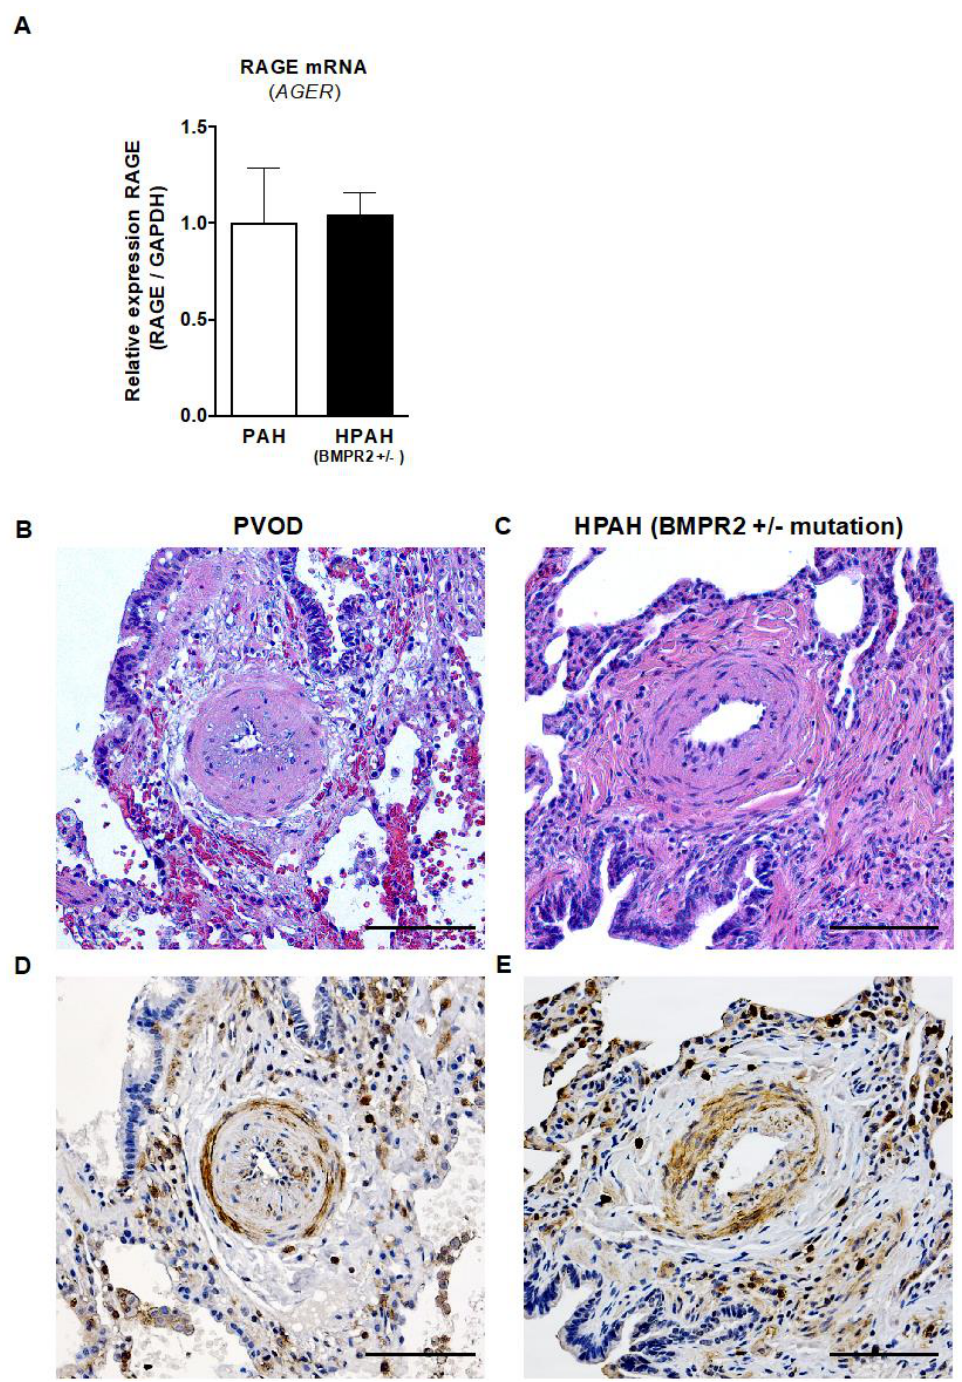
Figure 6. RAGE mRNA expression and immunohistochemistry in children with end-stage PAH and HPAH (heterozygous BMPR2 mutation). ( A ) The relative RAGE mRNA expression in children transplanted for idiopathic PAH or pulmonary veno-occlusive disease (IPAH + PVOD = PAH, n = 6) vs. children with heritable PAH (HPAH, BMPR2 +/ − mutation, n = 4) shows that a heterozygous BMPR2 mutation does not influence the relative RAGE mRNA expression in whole lung tissues from patients undergoing lung transplantation. Values are presented as mean ± SEM. Statistical test: Mann–Whitney U. ( B , C ) H&E images of distal pulmonary arteries of an 11-year-old patient with PVOD (B) and a 5-year-old patient with BMPR2 +/ − mutation (HPAH; C; scale bar, 100 µ m). ( D , E ). The corresponding images of RAGE staining show increased RAGE expression in vascular and inflammatory cells in the intima, media and adventitia of pulmonary arteries in both the 11-year-old patient with PVOD (D) and the 5-year-old patient with BMPR2 +/ − mutation (E; scale bar, 100 µ m). Abbreviations: BMPR2, bone morphogenetic protein receptor 2; PAH, pulmonary arterial